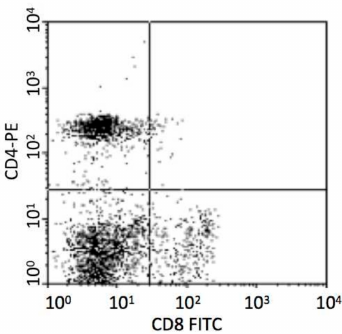
Figure 1. Analysis of porcine CD4 + and CD8 + T